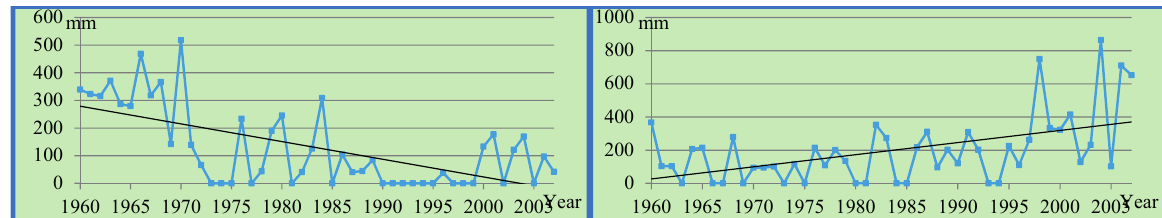
Figure 13. The most significant negative trend with a slope of − 12.822 ( left ) and the most significant positive trend with a slope of 11.127 ( right ) of the R95p index.